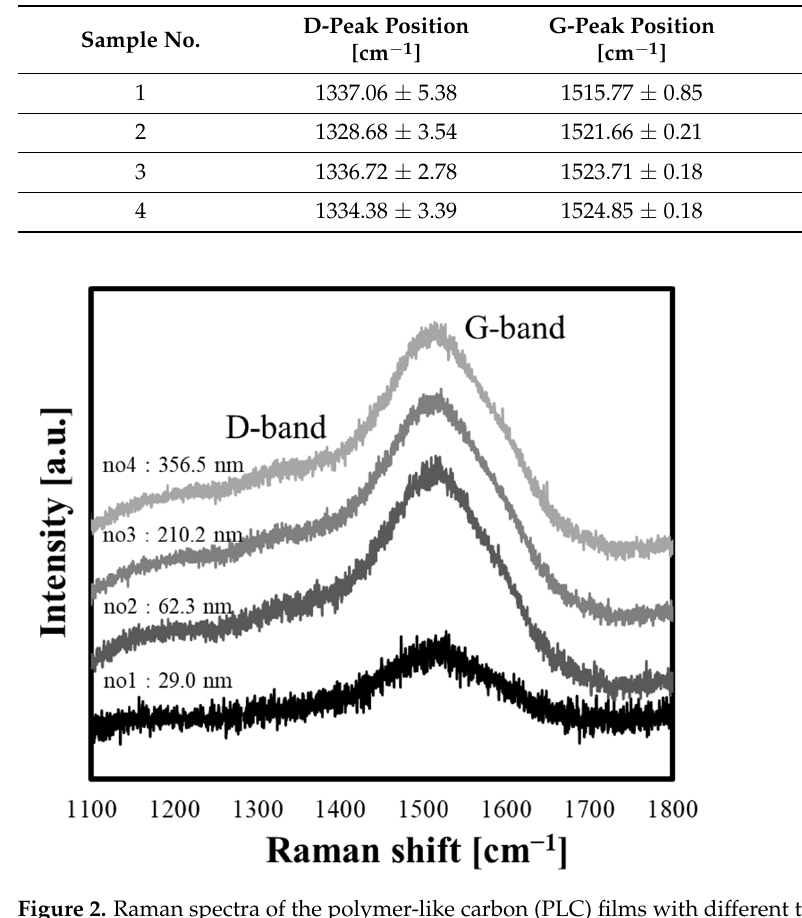
Table 4. Gaussian fitting results of Raman spectra.